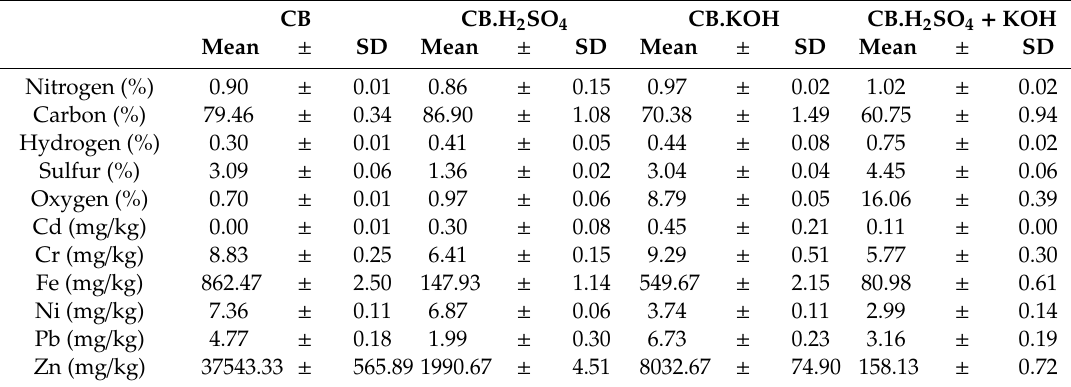
Table 2. Elemental analysis and metal content results of pyrolytic carbon black